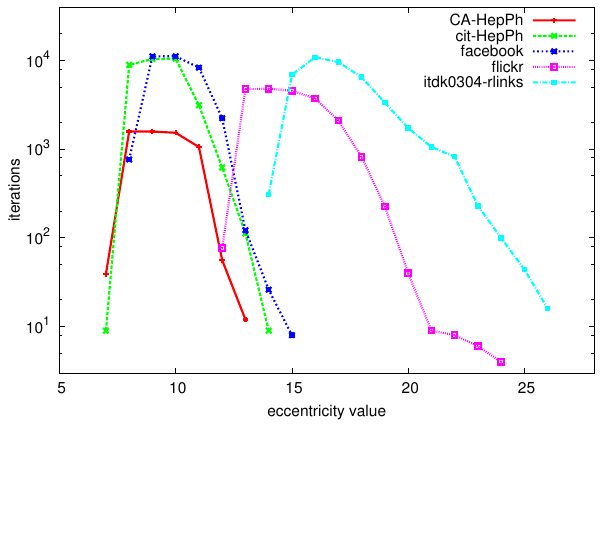
Figure 4. Eccentricity values (horizontal axis) vs . number of iterations to compute the eccentricity of all nodes with this eccentricity value (vertical